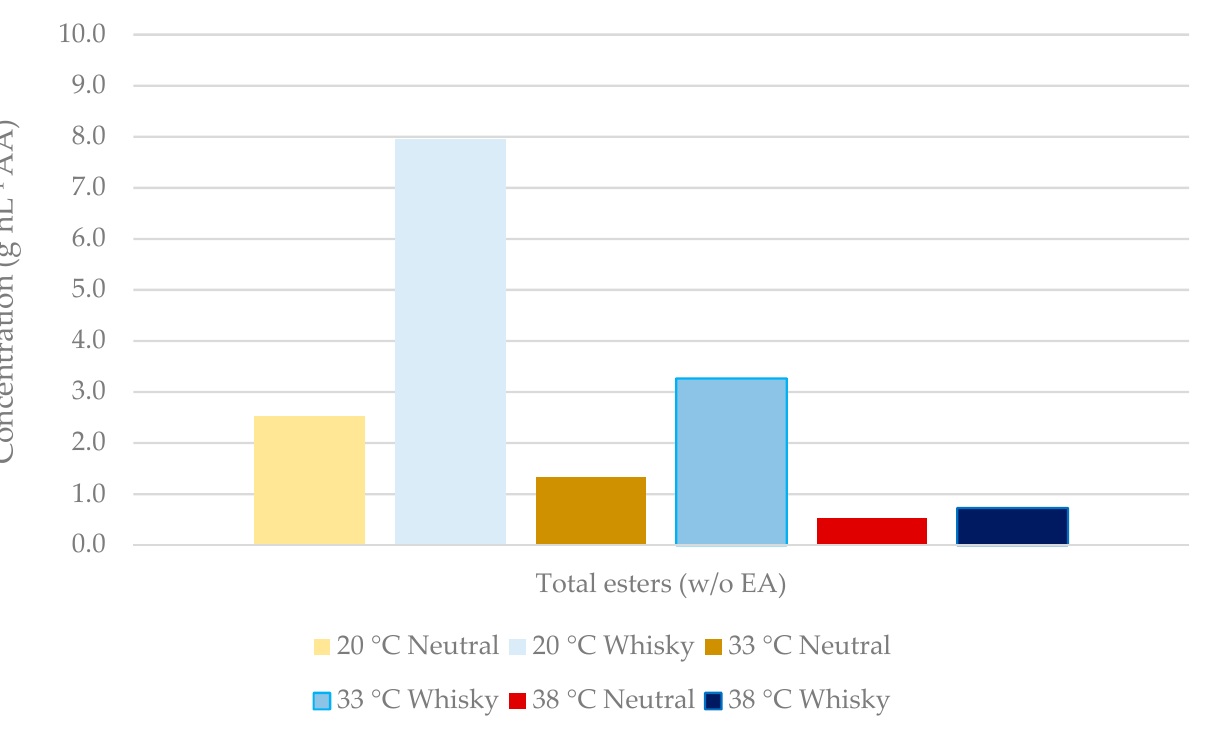
Table 6. Distilling yeast formats.